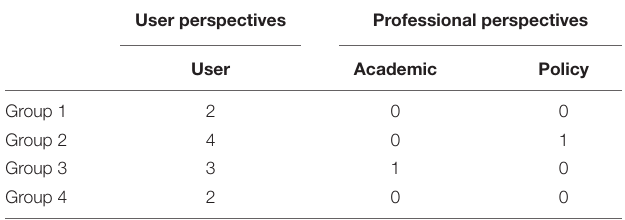
TABLE 2 | Workshop 2